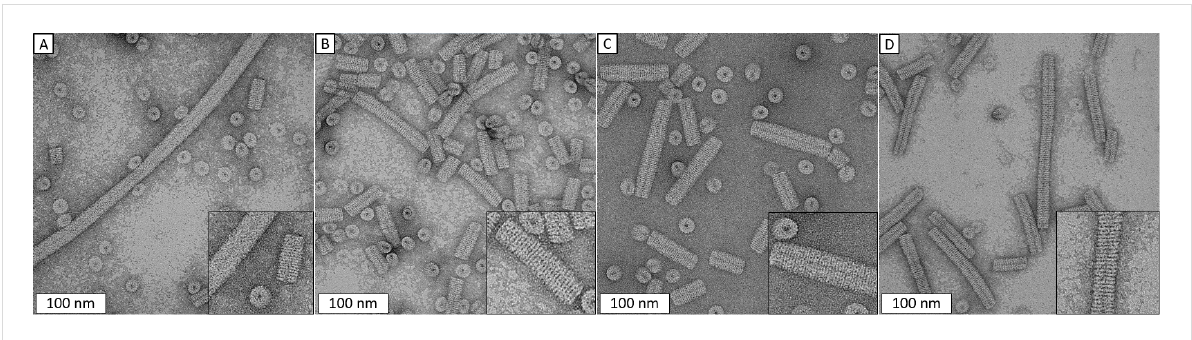
Figure 3: TEM images comparing TMV-cp assembled at pH 5.5 in different concentrations of ethanol. (A) no additive; (B) 3.5 mol % EtOH; (C) 5.0 mol % EtOH; (D) 10.0 mol %